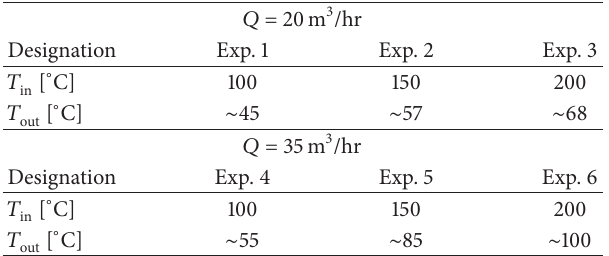
Table 1: Processing conditions of spray drying: different flow rates and temperatures of the drying